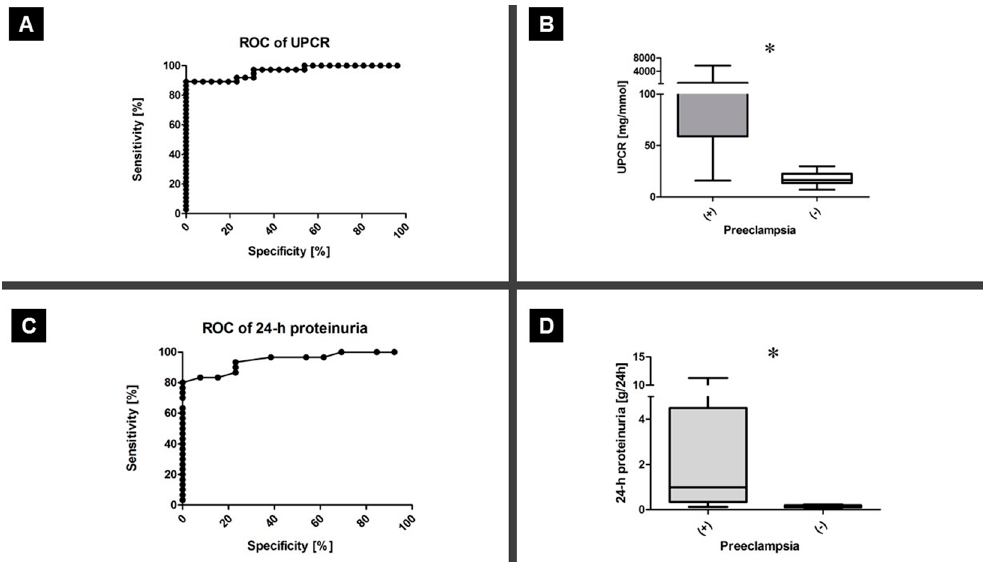
Figure 2. Proteinuria testing. Protein loss was assessed by determining the UPCR and performing the 24 h urine test. The UPCR cutoff of 30 mg/mmol was adequate for the diagnosis of preeclampsia ( A ). The UPCR values increased in the PE group ( B ). For the cutoff value of 0.26 g/24 h, the total protein The UPCR values increased in the PE group ( B ). For the cuto ff value of 0.26 g / 24 h, the total protein level in 24 h urine samples was adequate for the diagnosis of PE ( C ). Total protein was increased in the PE group ( D ); * p < 0.05. PE group ( D ); * p <